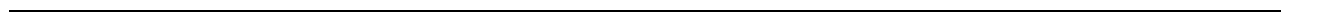
Fig. 6 SCAT7 regulates cell cycle progression and cell proliferation via FGF signaling. a – c Heatmaps showing upregulated and downregulated genes with corresponding molecular pathways and biological processes upon silencing of SCAT7 in HeLa ( a ), Caki-2 ( b ), and A549 ( c ) cell lines. d Western blot showing the proteins levels of FGFR2, FGFR3, AKT, Ser 473 Phospho-AKT (p-AKT S473), ERK1/2, and Phoshpo-ERK1/2 (p-ERK 1/2) upon silencing of SCAT7 in HeLa, Caki-2, and A549 cell lines. FGFR4 protein levels were only investigated in A549 cells. e Real-time qPCR validation (left panel) and Western blot (right panel) showing a signi fi cant reduction in the expression levels of CCND1 but not CDK4 . f Real-time qPCR validation of the expression levels of SCAT7 and its targets FGFR2 , FGFR3 , and FGFR4 in HeLa, Caki-2, and A549 cells upon SCAT7 KD with two independent siRNAs or shRNAs.